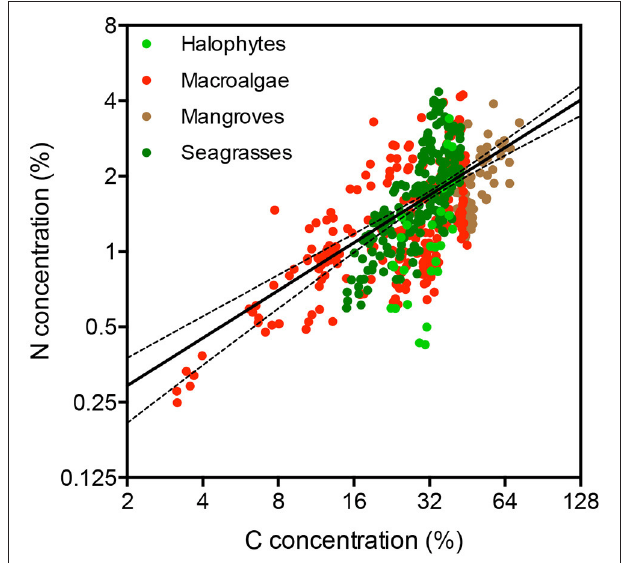
FIGURE 2 | Relationship between nitrogen and carbon concentration in the tissues of Red Sea mangroves (brown dots), halophytes (light green dots), seagrasses (dark green dots), and macroalgae (red dots). The solid line shows the fitted regression line across all plant types ± 95% CI of the